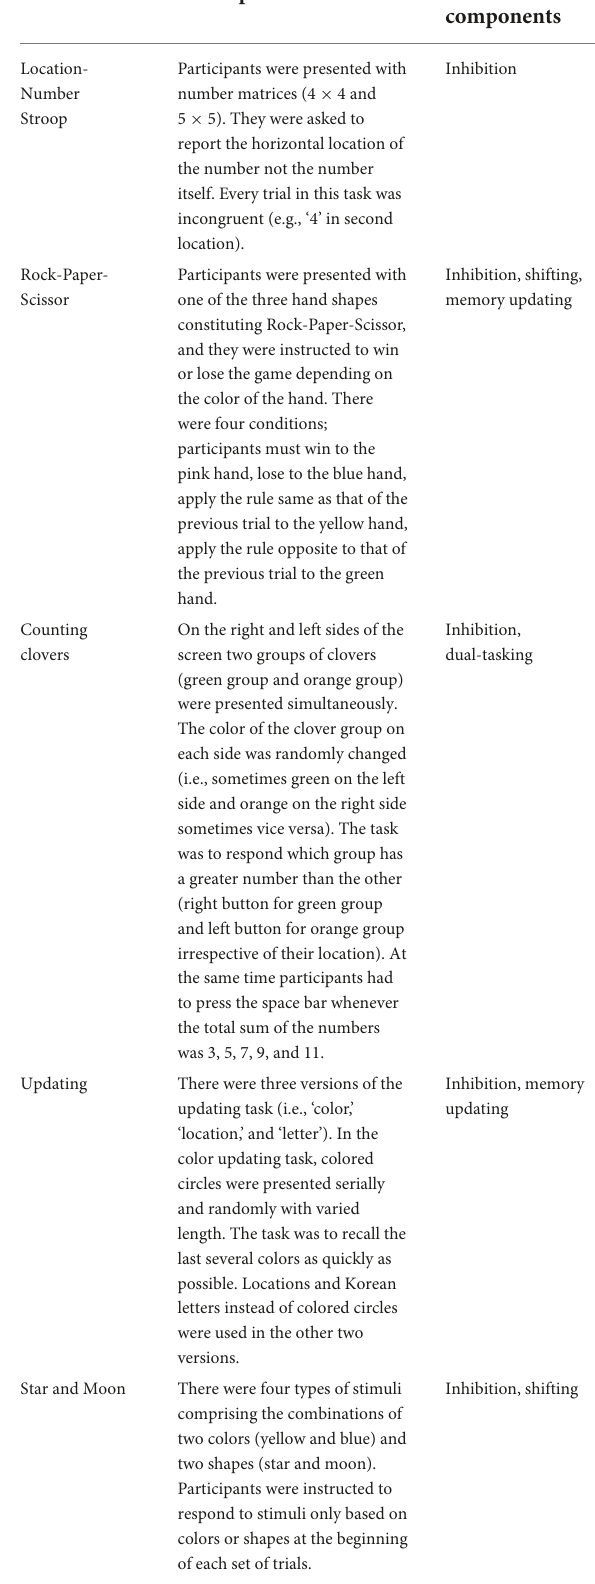
TABLE 2 A description of the tasks for training cognitive control.